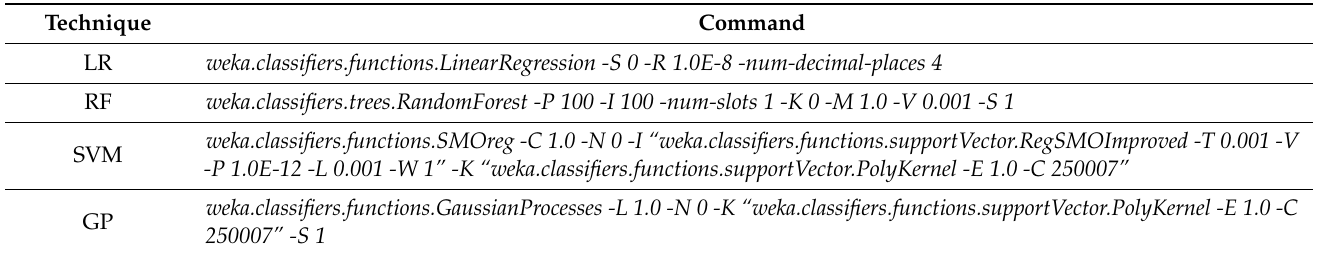
Table 4. WEKA commands for